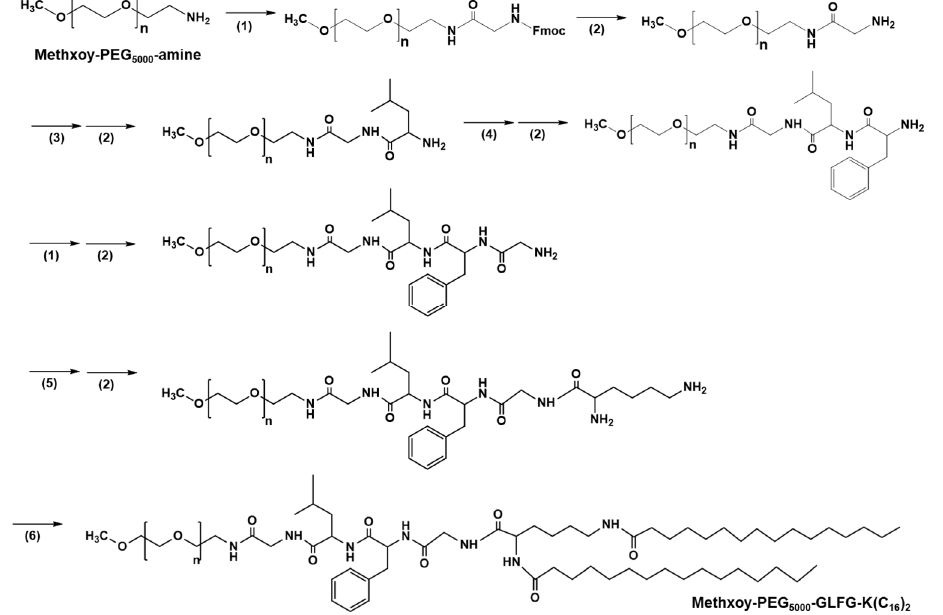
Figure 2. Synthesis scheme of PEG-GLFG. (1) HOBt (1-hydroxybenzotriazole hydrate), HBTU (2-(1H-benzotriazole-1-yl)-1,1,3,3-tetra-methyluronium hexaafluorophos -phate), DIPEA (N,N-diisopropylethylamine) and Fmoc-Gly-OH in DMF (dimethylformamide) for 16 h. (2) Piperidine 30% in DMF for 1 h 30 min. (3) HOBt, HBTU, DIPEA, and Fmoc-Leu-OH in DMF for 16 h. (4) HOBt, HBTU, DIPEA, and Fmoc-Phe-OH in DMF for 16 h. (5) HOBt, HBTU, DIPEA, and DiFmoc-Lysine-OH in DMF for 16 h. (6) HOBt, HBTU, DIPEA, and palmitic acid in DMF for 16 h.